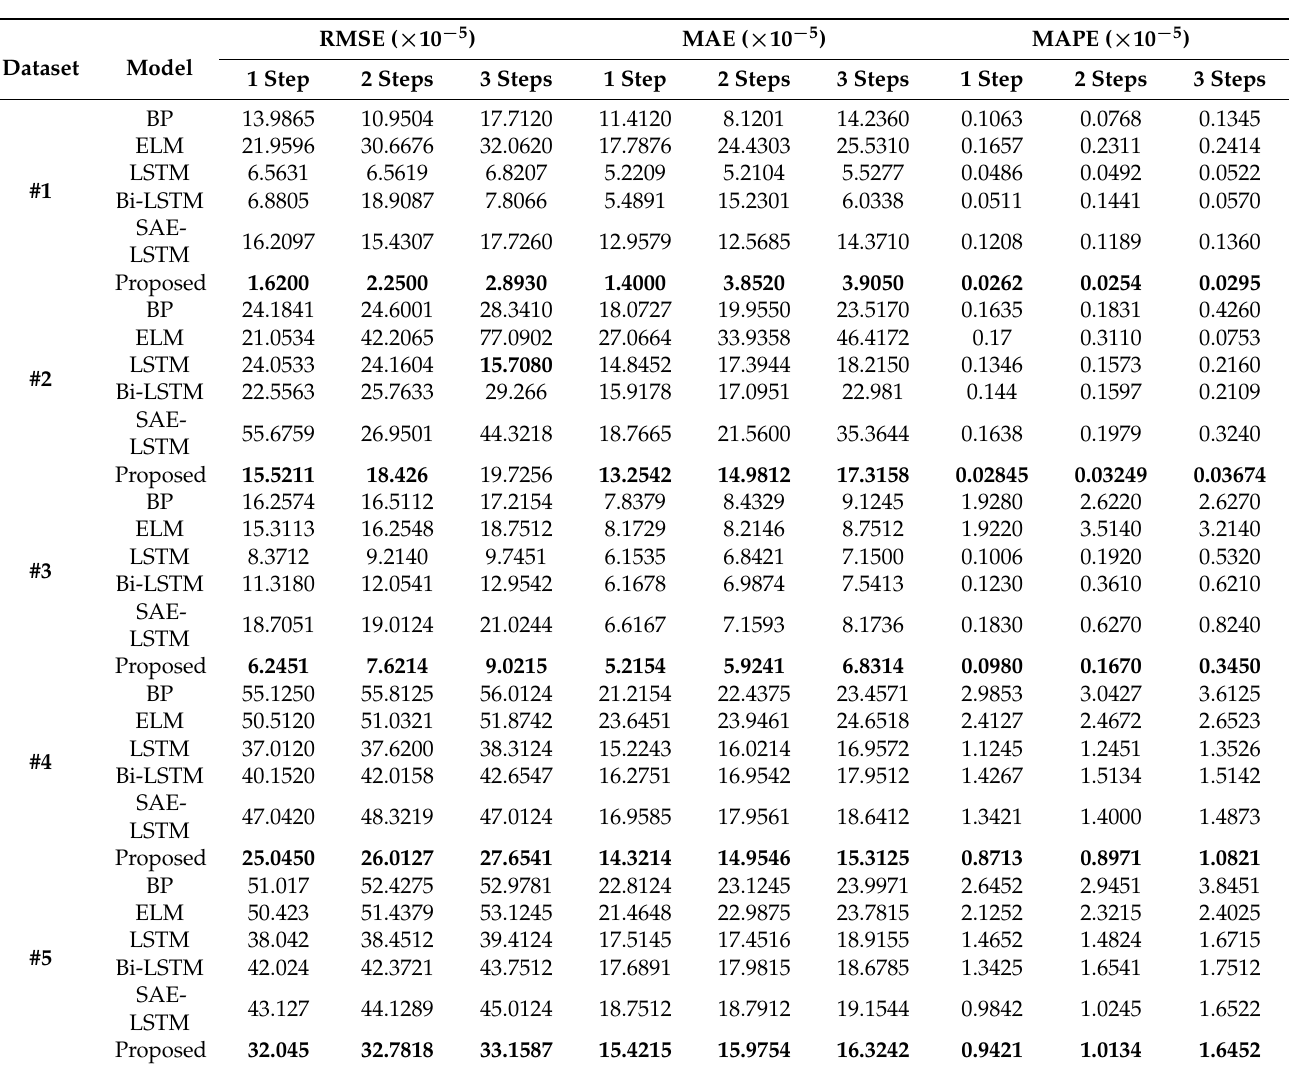
Table 5. The roll angle prediction errors of different models.